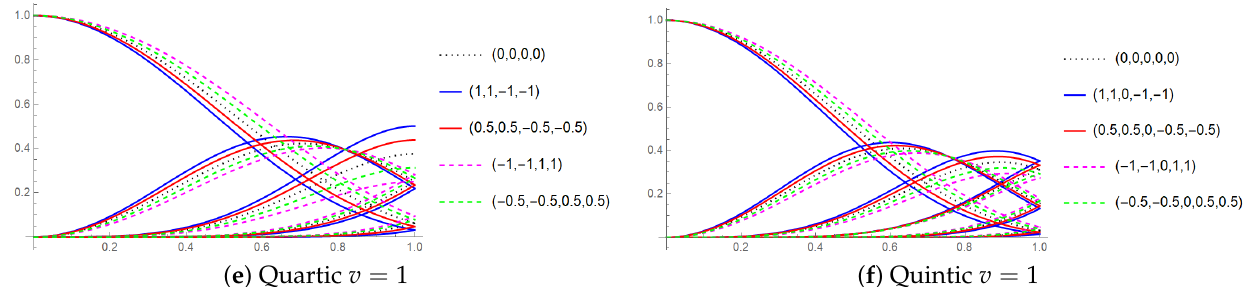
Figure 2. Quartic and quintic fractional Bézier basis functions with multiple values of v and shape